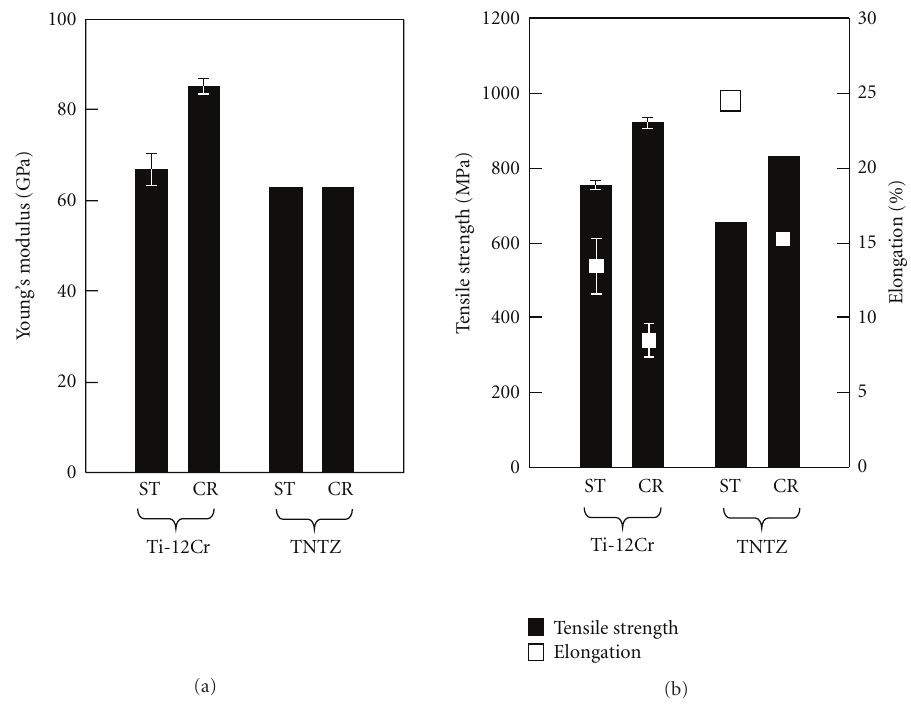
Figure 13: Comparison of mechanical properties of the designed alloy (Ti-12Cr) and those of an alloy with low Young’s modulus (TNTZ). (a) Young’s moduli of Ti-12Cr-ST, Ti-12Cr-CR, TNTZ-ST, and TNTZ-CR. (b) Tensile strength and elongation of Ti-12Cr-ST, Ti-12Cr-CR, TNTZ-ST, and TNTZ-CR. Young’s modulus of Ti-12Cr clearly increases on account of cold rolling, but that of TNTZ shows almost no change. Ti-12Cr exhibits a relatively high tensile strength and acceptable elongation in comparison with